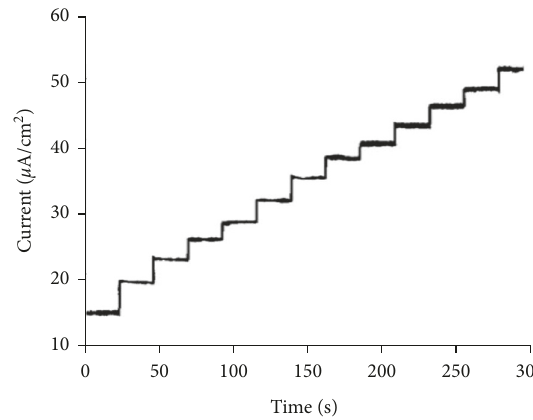
Figure 10: Amperometric response curve of the PB-modified electrode for successive addition of 0.01 M H 2 O 2 . Figure 7: Effects of different reaction conditions on PB particle size